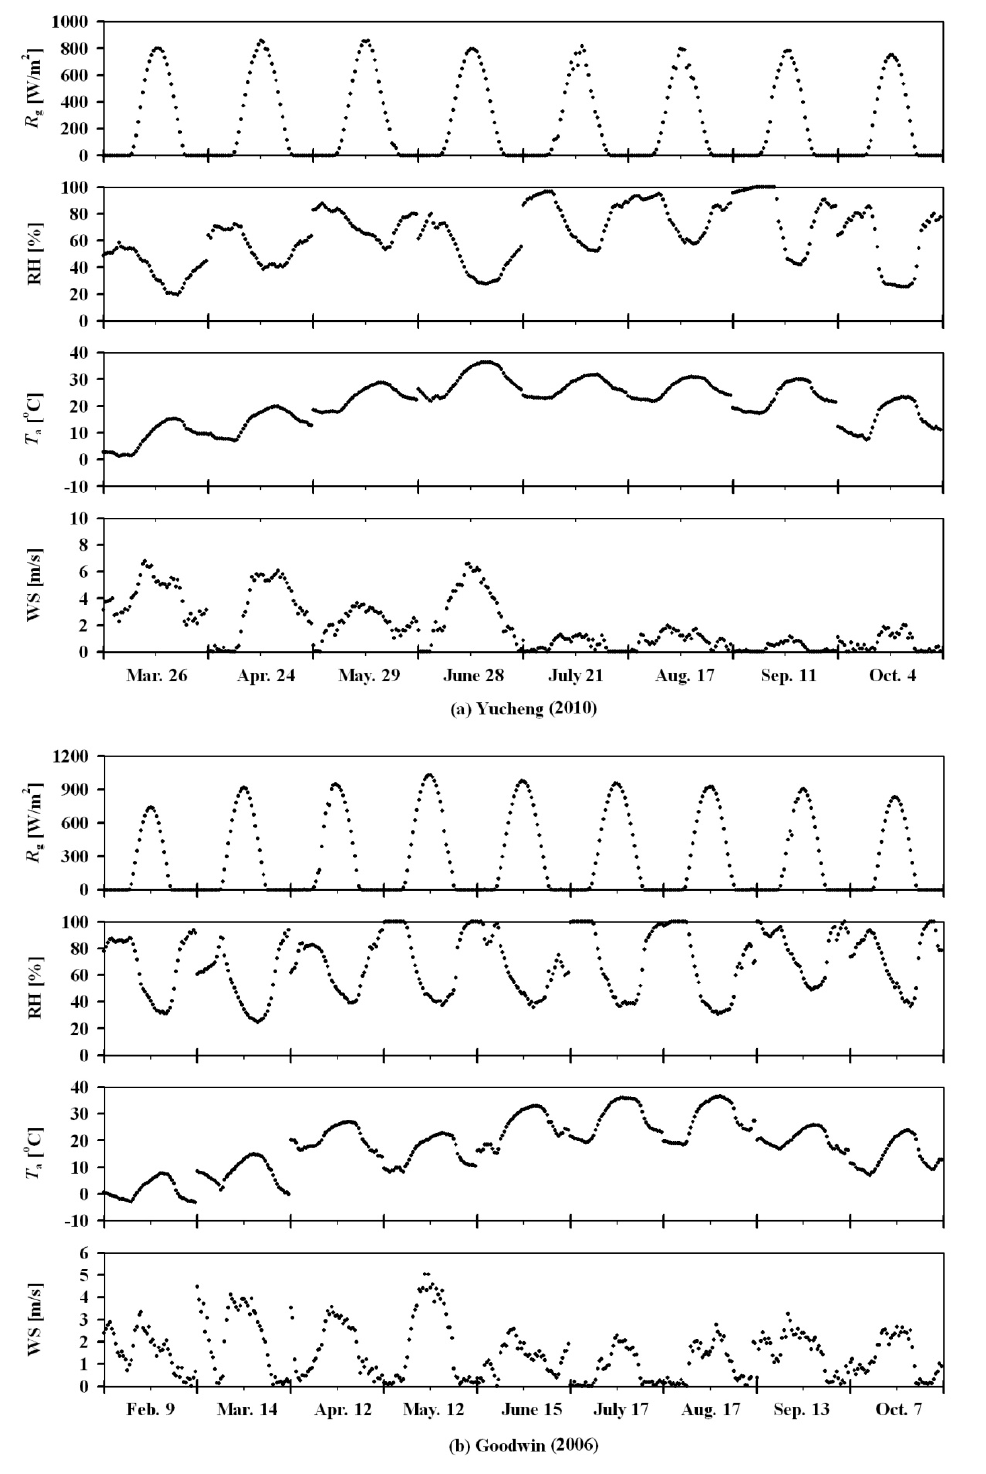
Figure A1. Atmospheric forcing from ( a ) the Yucheng site in 2010, ( b ) the Goodwin site in 2006, ( c ) the Cottonwood site in 2008, and ( d ) the Audubon site in 2006 ( R incoming radiation; RH is the relative humidity; T wind